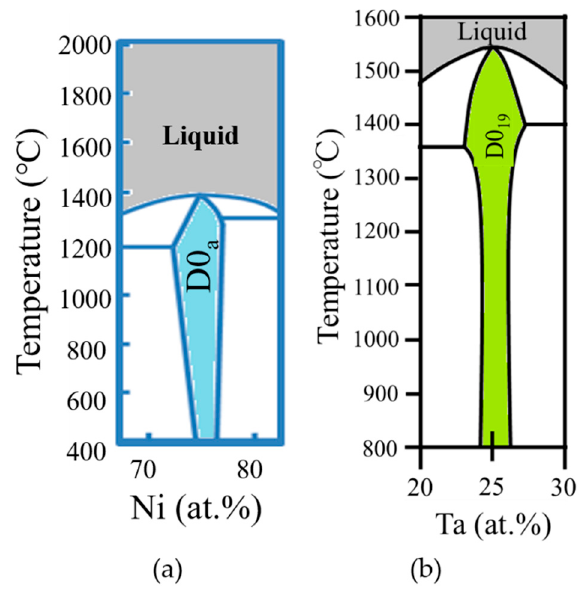
Figure 22. Phase diagrams of ( a ) Ni-Nb binary alloy and ( b ) Ni-Ta binary alloy.